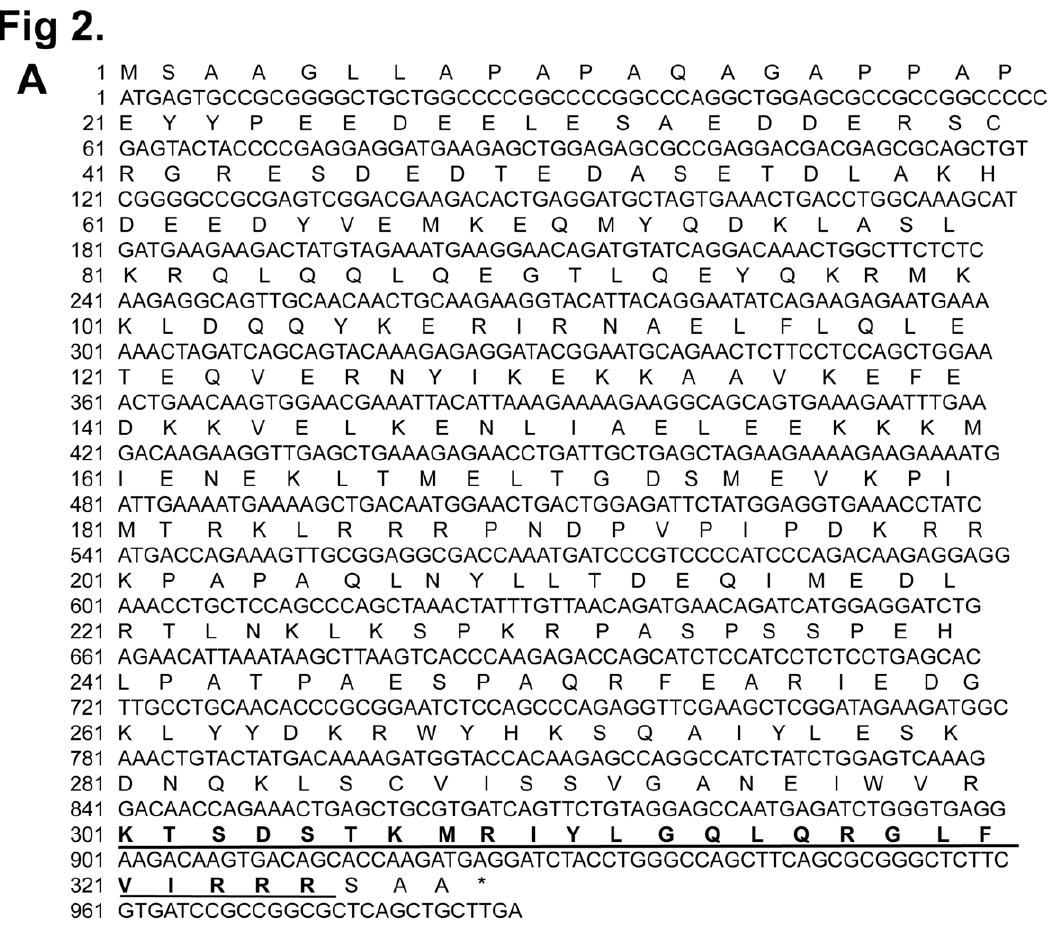
Figure 2. Binding of SDS3 to HA . A ) Identification of three overlapping HABMs in SDS3 nucleotide and deduced amino acid sequence. HABMs are represented in bold face and underlined (301-325 aa). B ) Comparison and alignment of SDS3 amino acid sequence and BH-P. C ) SDS3 binds with HA. CPC precipitation assay was performed on 293 T cells transfected with USP17, SDS3 and SDS3/USP17-shRNA. Proteins precipitated with HA were subjected to Western blot analysis with either an anti-myc or an anti-Flag antibody. D ) USP17 and SDS3 directly bind with HA. CPC precipitation assay was performed on purified GST-tagged USP17 or His-tagged SDS3 proteins separately. Western blot analysis with either an anti-GST or an anti-His antibody was performed.